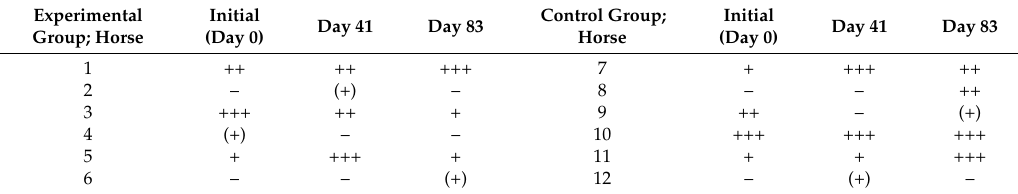
Table 3. Incidence of neutrophil cells in tracheal mucus in individual horses. Experimental Group;